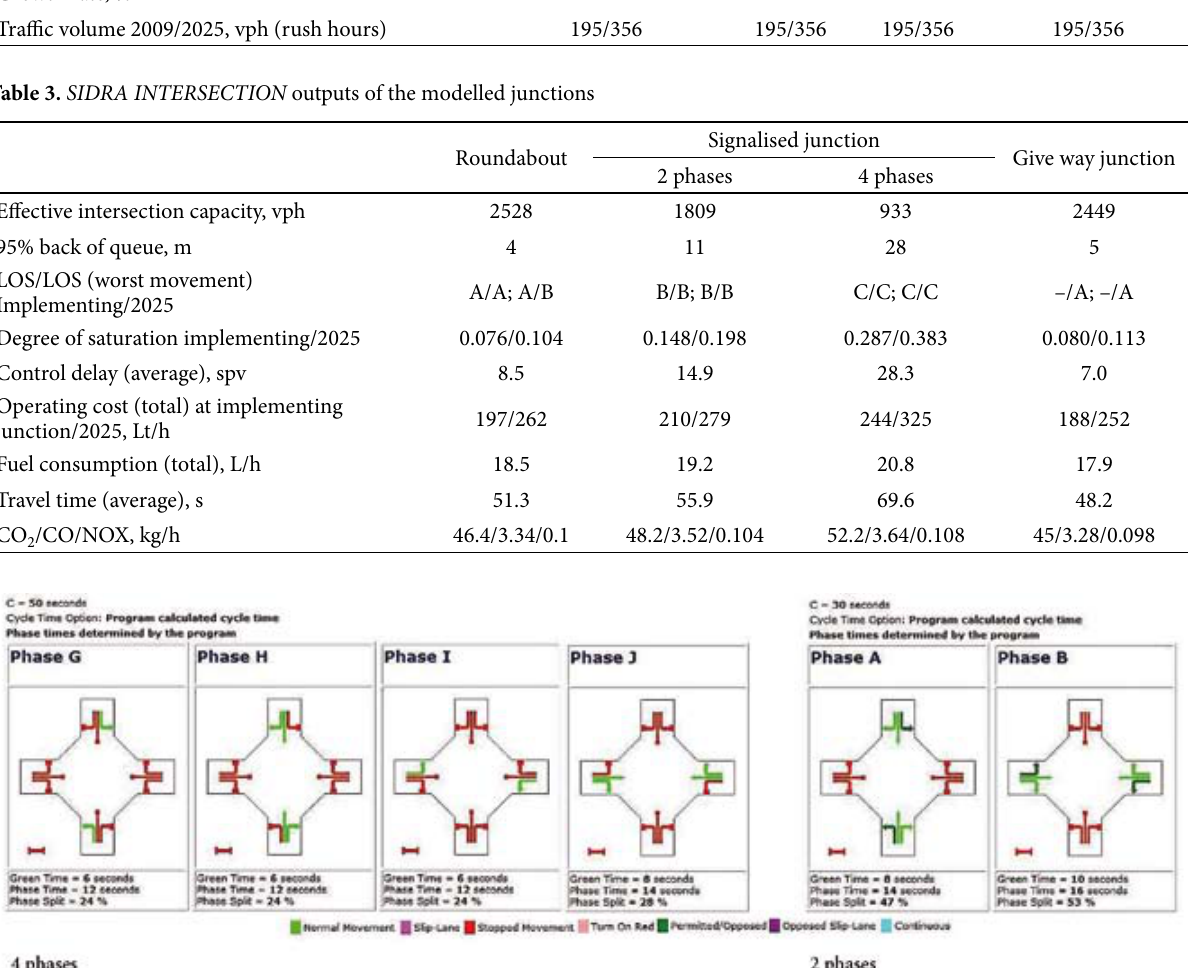
Fig. 6. Phases of signal controlled